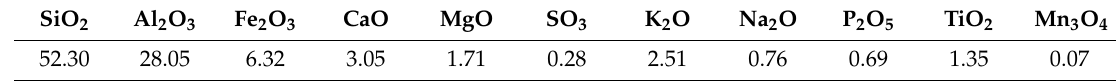
Table 1. Analysis of fly-ash (FA). Oxides contents in wt.%.